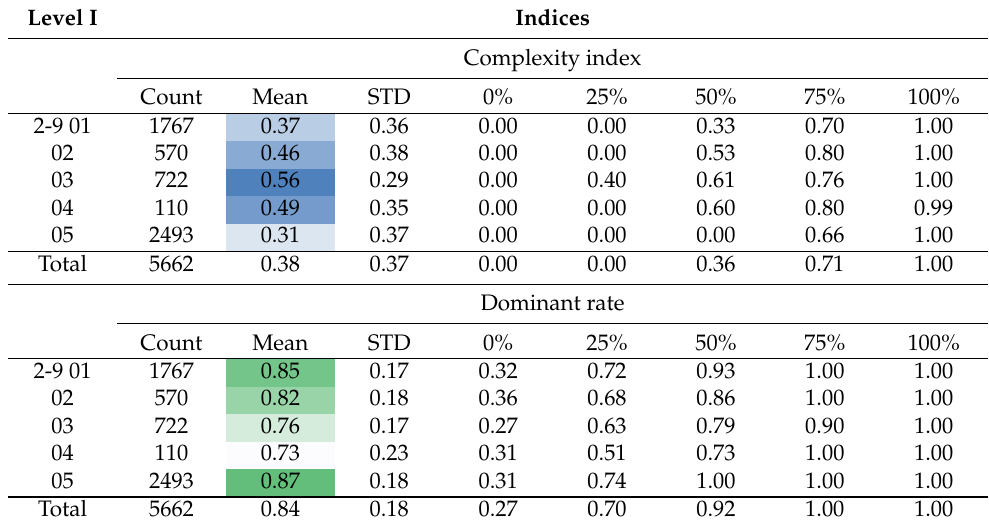
Table 6. Statistics of complexity index and dominant rate for each Level I land use category. Definition for each land use category can be seen in Table 1.